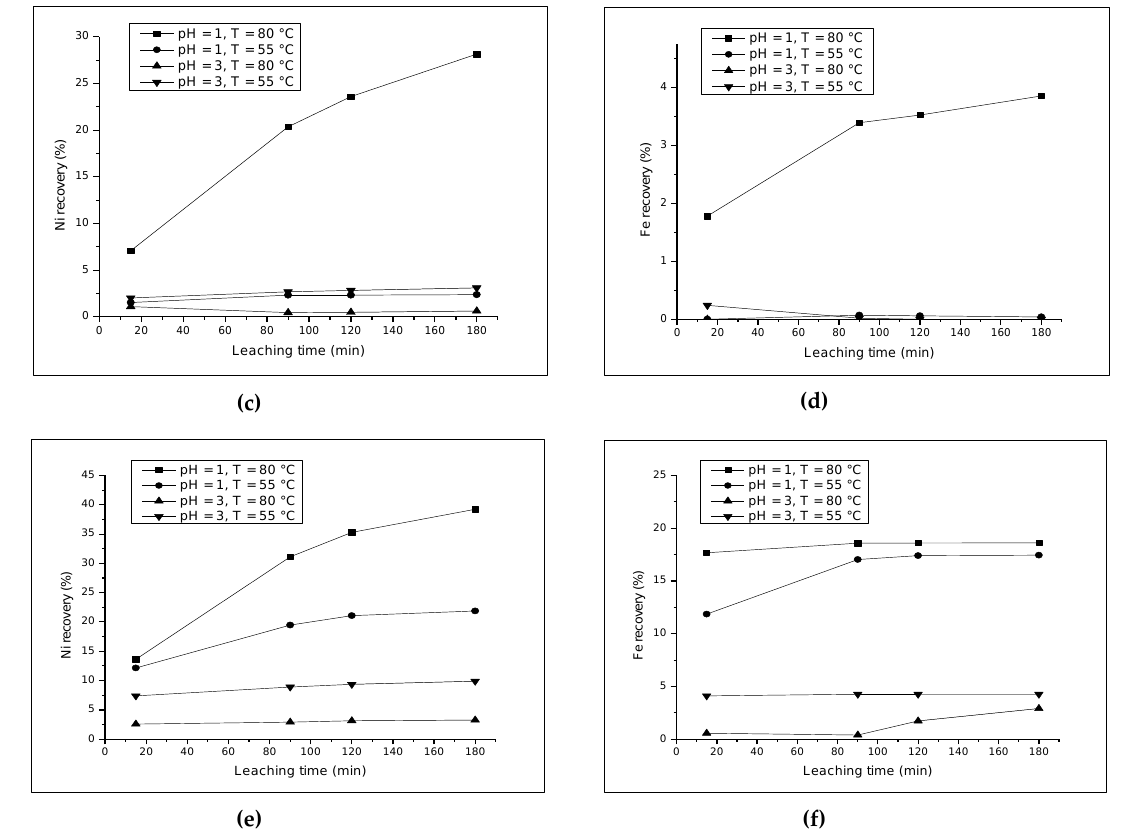
Figure 7. Recovery of nickel and iron using alkali roasting pretreatment and leaching using SO 2 -dissolved air in water: ( a , b ) Ore + Na 2 SO 4 ; ( c , d ) Ore + Na 2 SO 4 ; ( e , f ) Ore + NaOH.